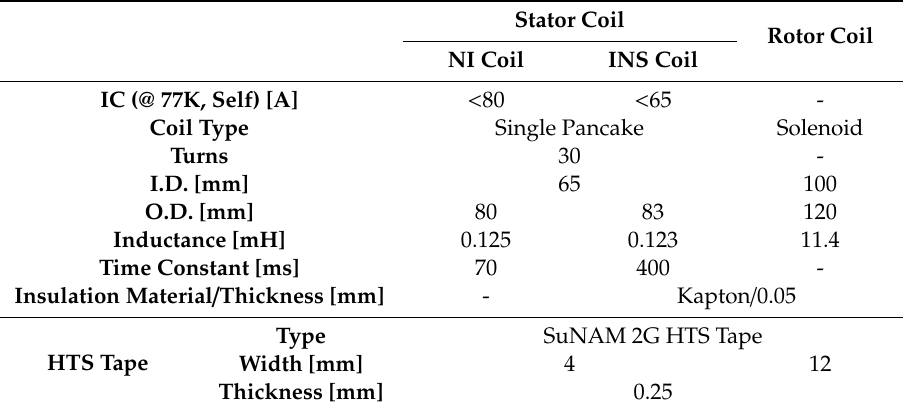
Figure 10. Experimental set-up for verification of the simulation results. Table 2. Specifications of superconducting coil parameters and